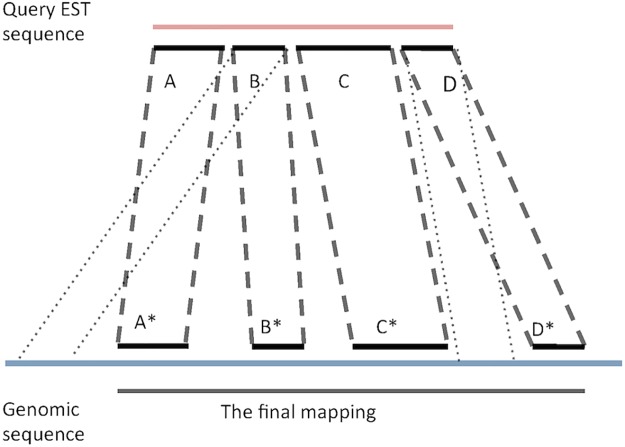
Illustration of EST mapping process.The HSLAs (A, A*), (B, B*), (C, C*), and (D, D*) are used to report the final mapping.